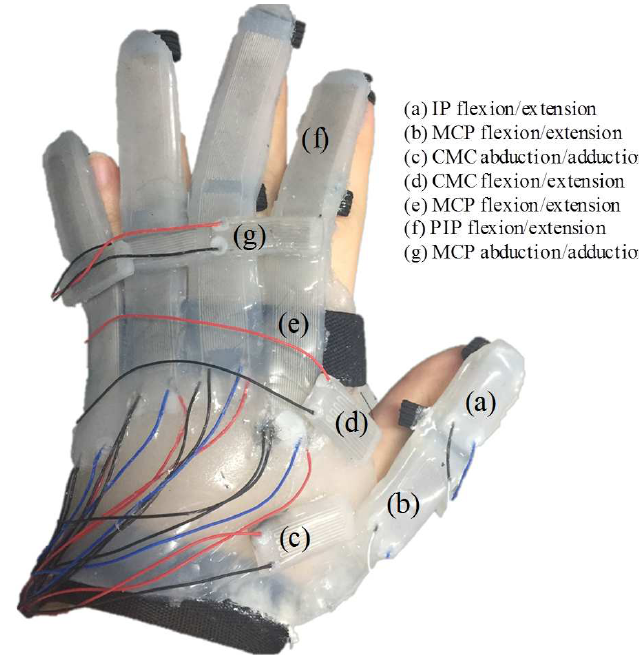
Figure 3. Configuration of the soft sensor-based 3-D finger motion measurement system.